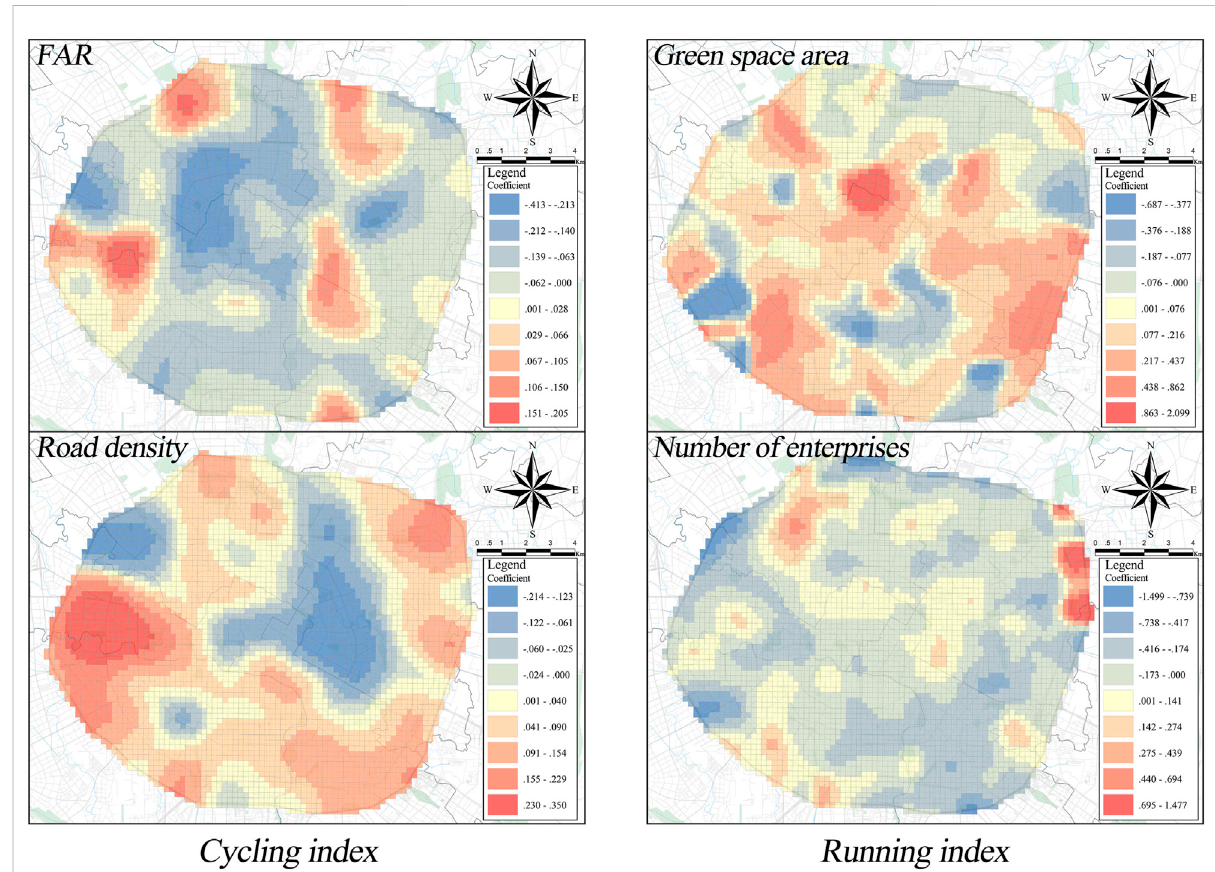
FIGURE 9 The spatial distribution of the coef fi cient of FAR, road density, green space. Area, and the number of enterprises in the GWR